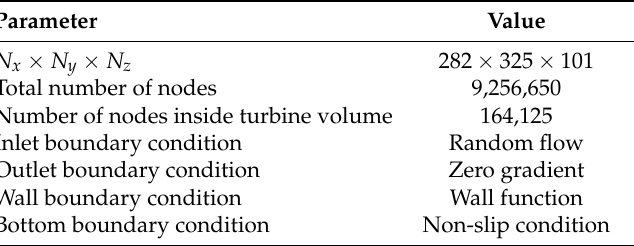
Table 2. Main grid characteristics used in both